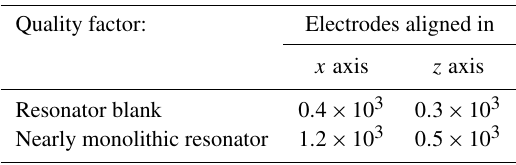
Figure 9. Temperature dependence of the resonance frequency of the nearly monolithic resonator excited via electrodes along the z axis (left axis) and the corresponding Q factor (right axis). Table 4. Q factor of the nearly monolithic resonator and the res- onator blank, both excited with electrodes aligned along the x and z axis. The data represent the average values in the high-temperature range of approximately 800 to 1000 ◦